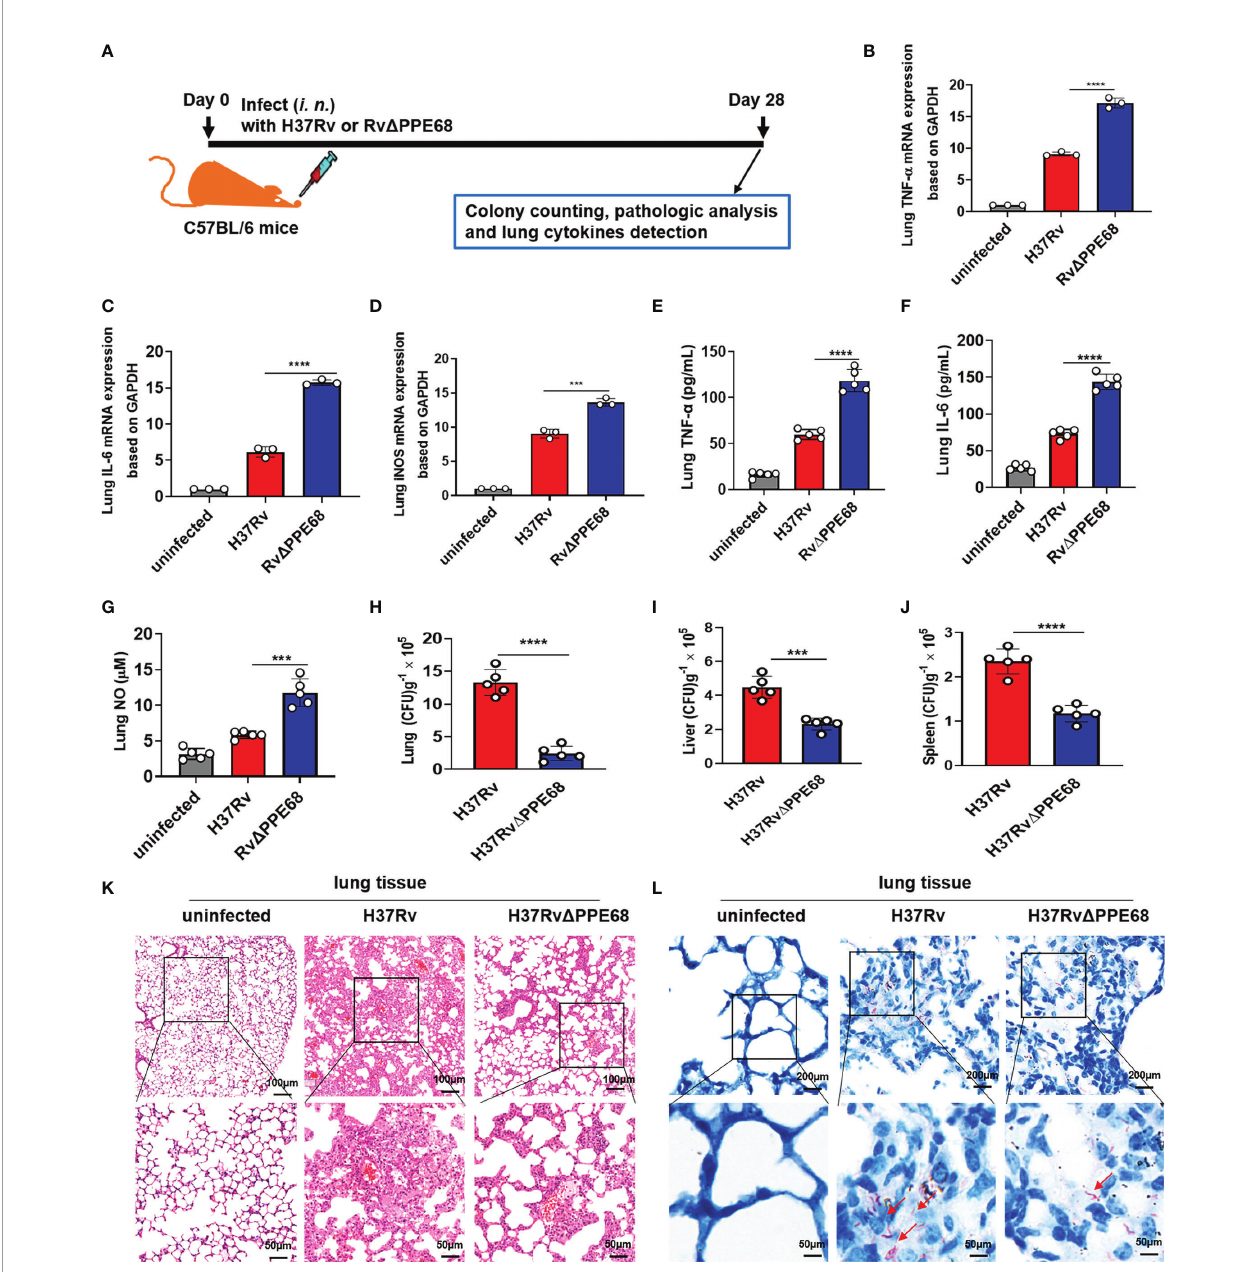
FIGURE 5 | Mtb PPE68 inhibits the production of TNF- a , IL-6 and NO and promotes mycobacterial survival in mice. (A) Procedure for the mouse Mtb infection experiment. (B-D) RT-qPCR analysis of lung TNF- a (B) , IL-6 (C) and iNOS (D) mRNA expression of C57BL/6 mice infected ( i.n. ) with 5 × 10 4 CFUs of H37Rv or Rv D PPE68 (n = 5, each group). (E-I) Lung TNF- a (E) , IL-6 (F) , NO (G) concentrations were measured by ELISA, and bacterial burdens in the lungs (H) , liver (I) , and spleen (J) of infected mice were determined by CFU counting on 7H10 agar plates. (K, L) Lung tissue sections were analyzed with H&E (K) and acid-fast staining (L) . The red arrows indicate acid-fast staining-positive bacteria. The data are expressed as the mean ± SD of three independent experiments for B-J, and two tailed unpaired t test was used to calculate statistical signi fi cance. *** p < 0.005; **** p <